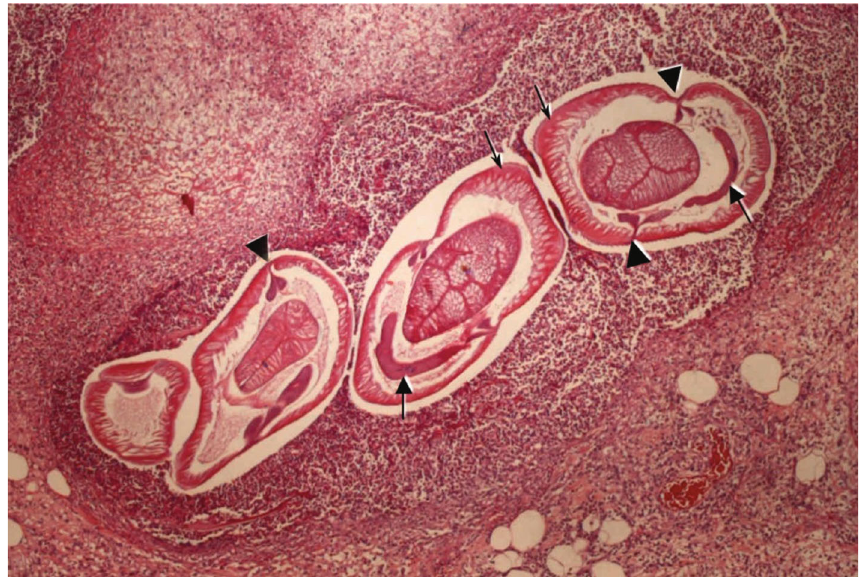
Figure 8: Transverse intestinal wall biopsy specimen, which demonstrates Anisakiasis larva within the submucosa. Thin arrows highlight polymyarial muscle cells, separated into × 4 quadrants by the chords demonstrating two wing-like lobes (arrowheads). Banana-shaped excretory cells are organized ventral to the intestine (thick arrows). (Image obtained with permission from Mattiucci et al.